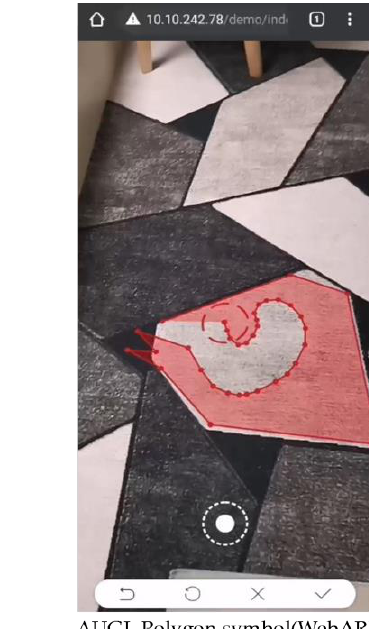
Figure 15. The linear symbol algorithms are rendered consistently in three cross-platform environments.